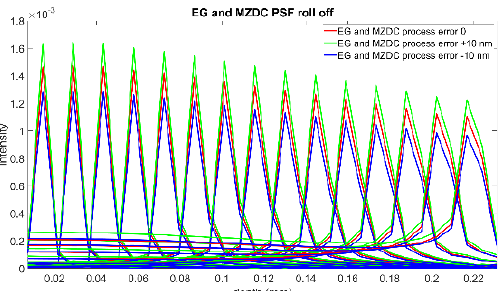
Figure 14. PSF roll-off from the MZDC interrogated with AWG.